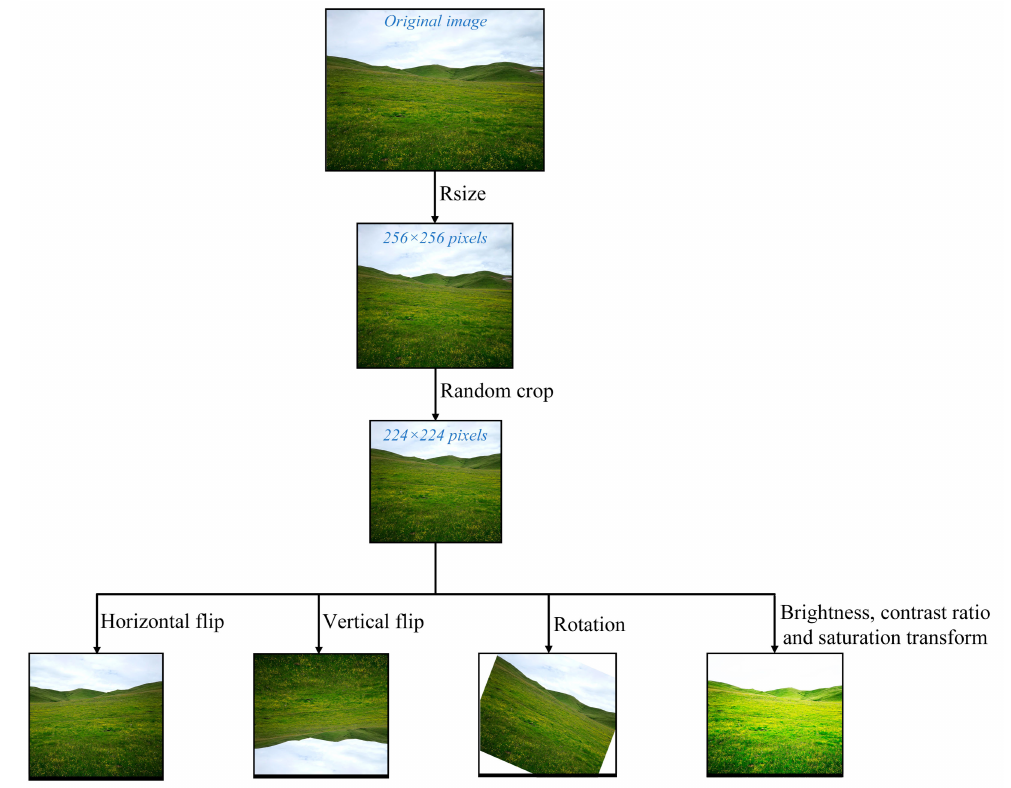
Figure 2. Examples of image